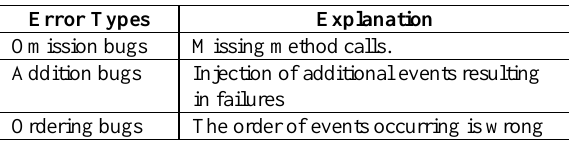
Table 5. Three Types of